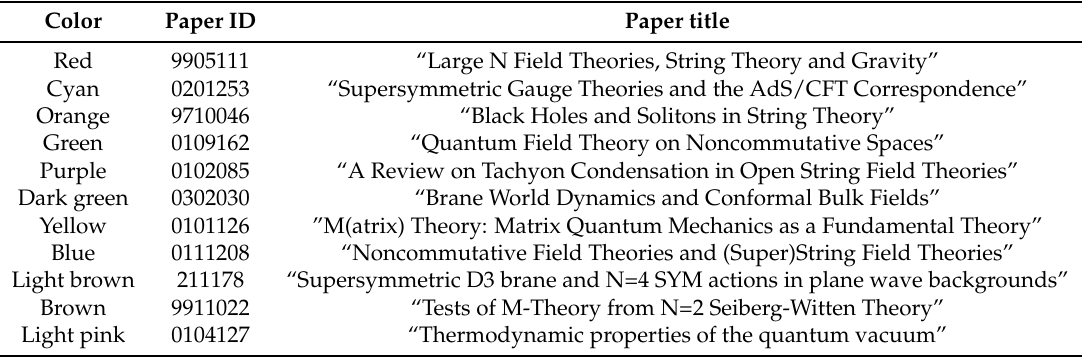
Table 3. Detailed information of selected points in singular vector